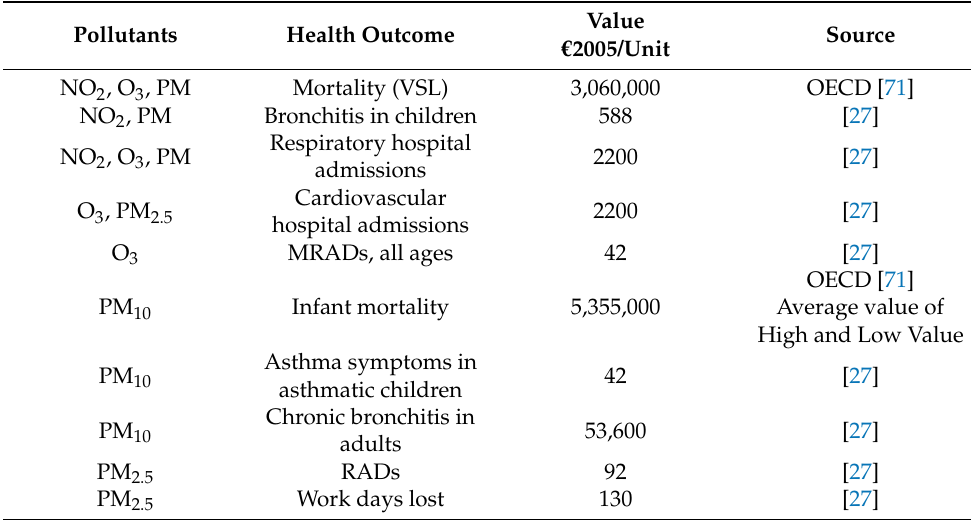
Table 2. Monetary values (V) used for the health impact assessment, in € 2005